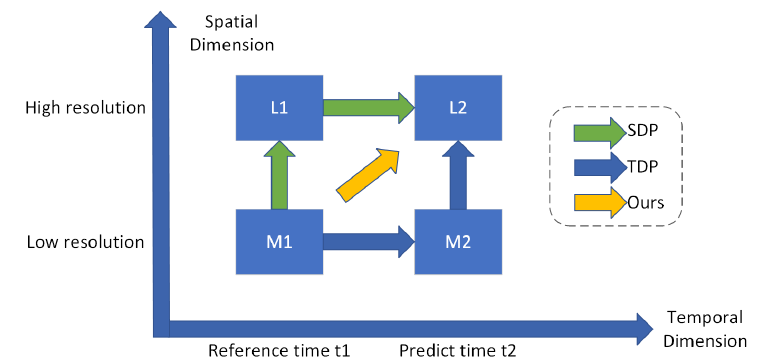
Figure 1. Dimensional analysis of the spatiotemporal fusion